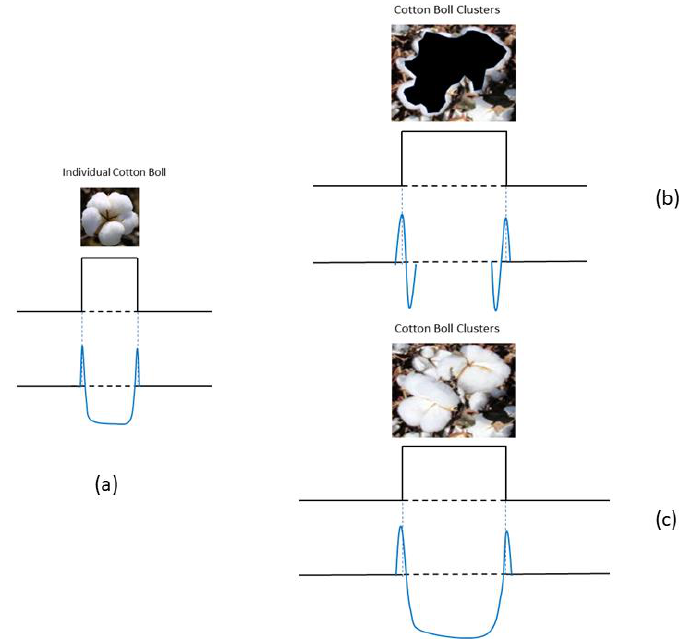
Figure 4. CUC quantification ( a ) LoG of UAV RGB images of individual small cotton boll; ( b ) LoG of UAV RGB images of large cotton boll/boll clusters; ( c ) thresholding of LoG of UAV RGB images of large cotton boll/boll clusters.